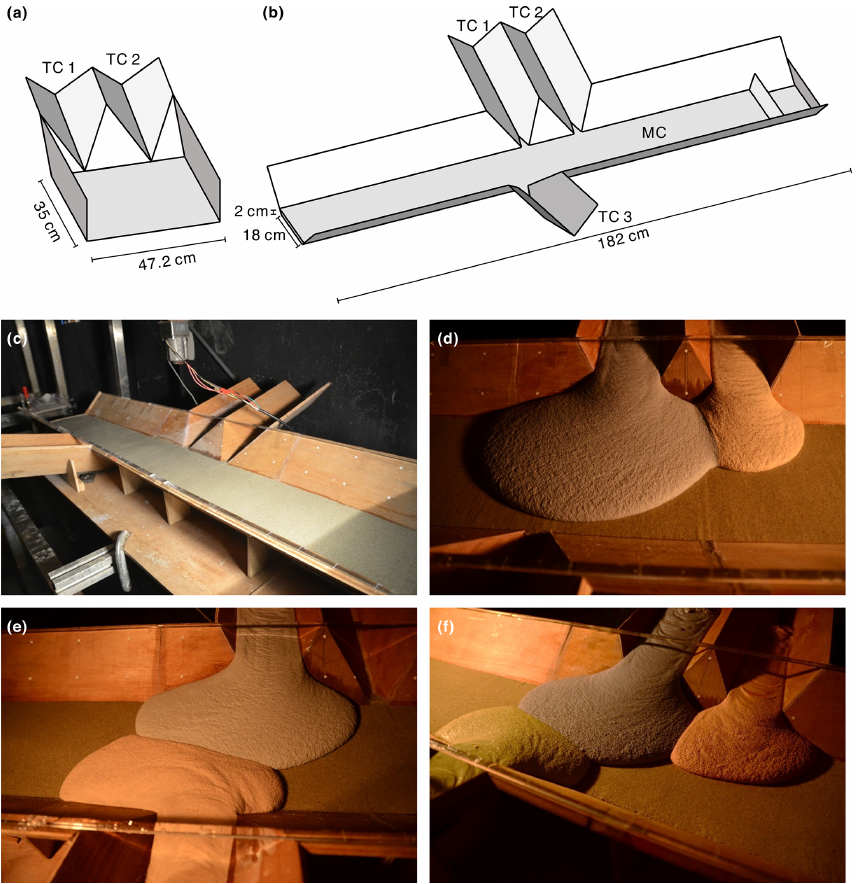
Figure 9. Experimental setup and photos: (a) flume geometry for the canyon–plain experiments (T01–T04); (b) flume geometry for the canyon–valley experiments (T11–T15); (c) initial conditions for runs T11–T14; (d–f) final deposits for runs T12, T13, and